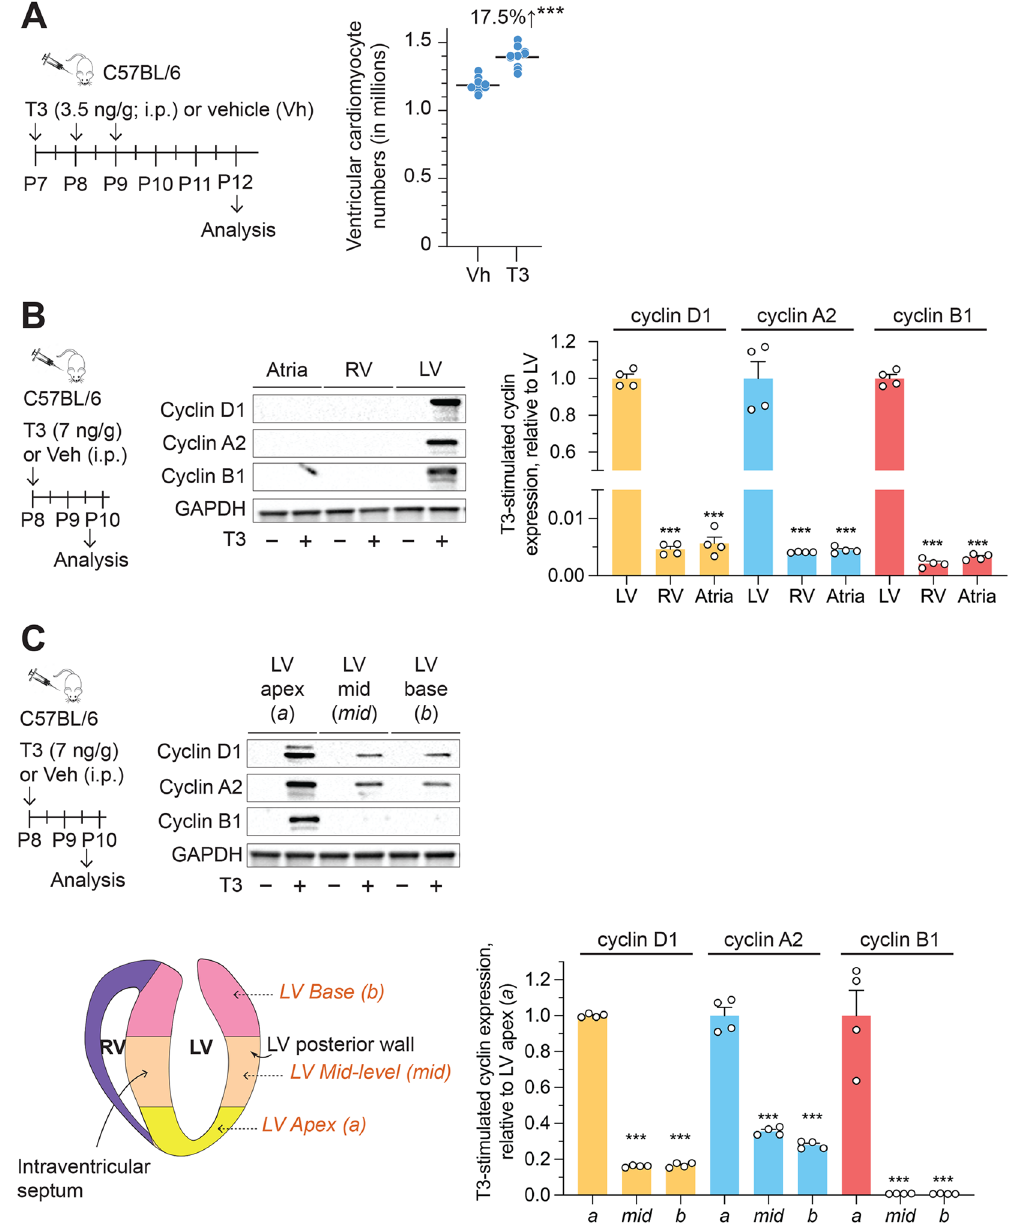
Figure 1. T3 increases ventricular cardiomyocyte proliferation and cyclin expression in the LV myocardium of post-P6 hearts. ( A ) Exogenous T3 administration increases ventricular cardiomyocyte numbers in P7 mice. *** P < 0.001. Schematics illustrate experimental protocol. ( B , C ) In vivo T3 administration increases cyclin D1, A2, and B1 expression in the LV, but not atria or right ventricle (RV) ( B ) and, within the LV, preferentially in the apex compared to the mid LV or base ( C ). Histograms show the quantitation of the data in ( B , C ). Immunoblots in ( B , C ) are representative of 4 biologically independent replicates. Schematics illustrate experimental protocol. Error bars indicate SEM. *** P <